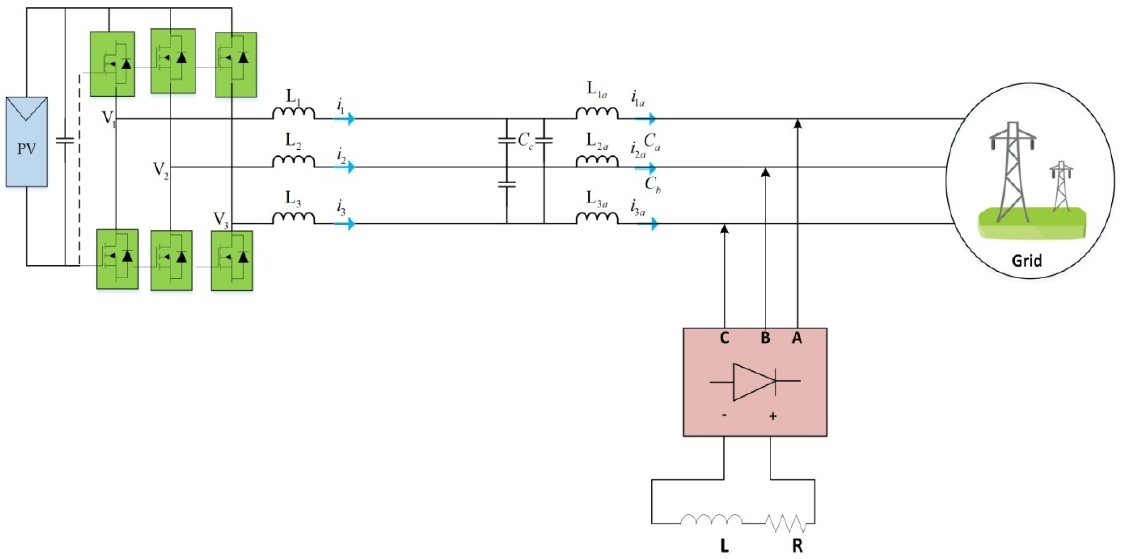
Figure 1. Main components of grid-connected PV systems.